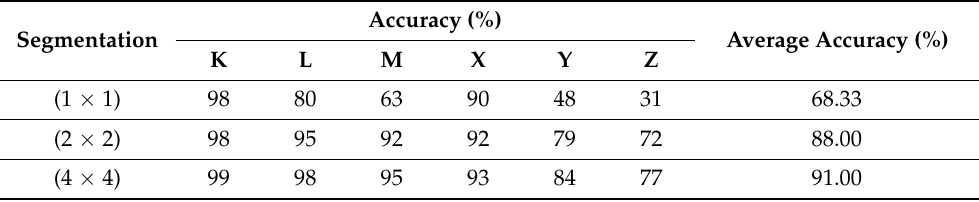
Table 9. Comparison of the results obtained using different divided blocks with occlusion by scarf.